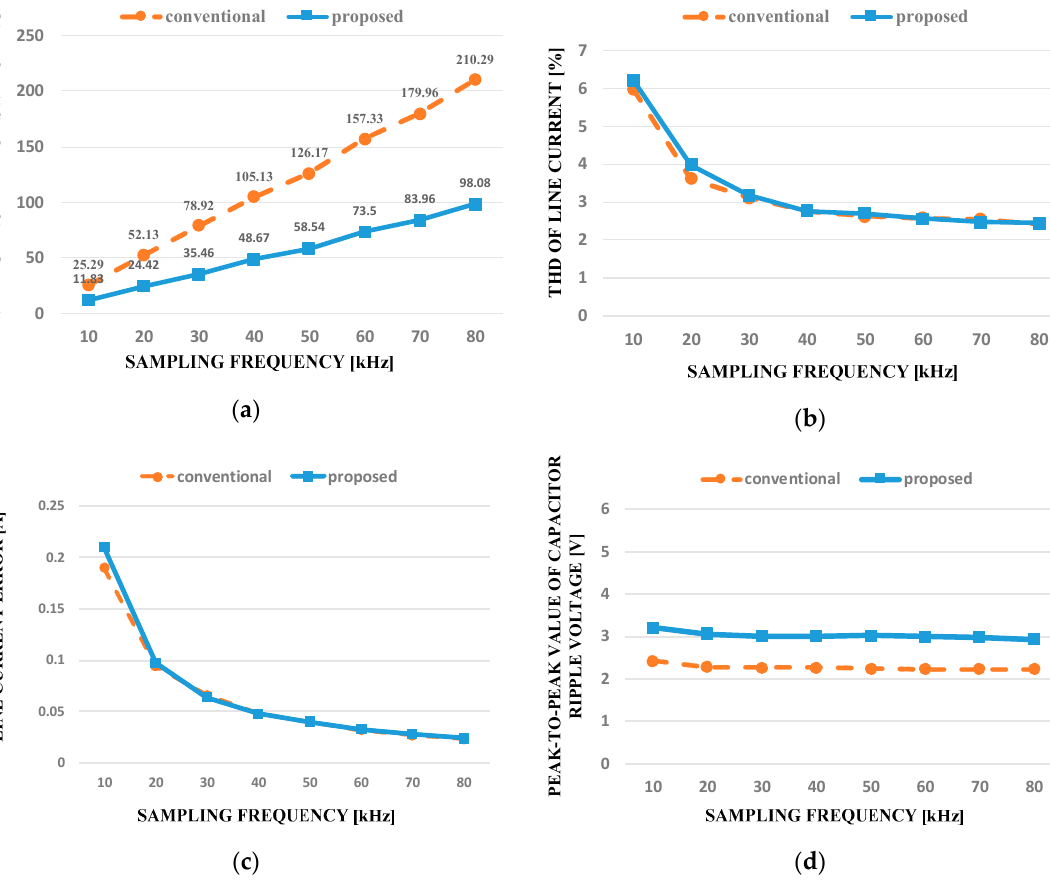
Figure 6. Comparison results obtained by conventional MPC method and proposed method vs. sampling frequency: ( a ) number of switchings; ( b ) THD values of source currents; ( c ) current errors; and ( d ) peak-to-peak values of capacitor ripple voltages.